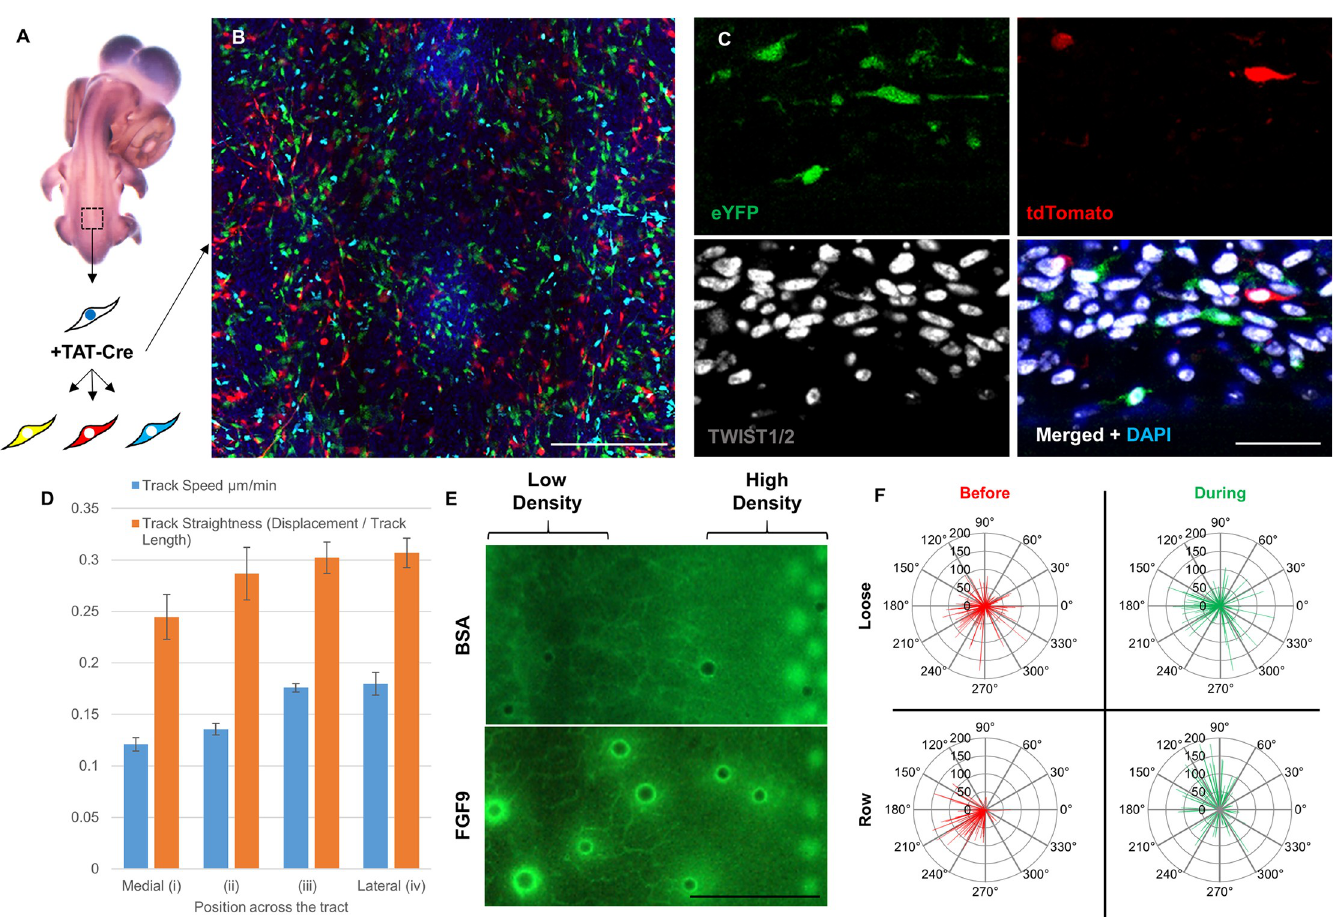
Fig 6. Individual mesenchymal cell movement and morphology are unaffected by cell density. (A) Cells of the Chameleon line express Nuclear Blue until exposure to Cre recombinase, which causes cells to express one of three colours of cytoplasmic fluorescent proteins: red, cyan, or yellow. (B) E6 Chameleon skin treated with TAT-Cre and cultured for 24 hours, demonstrating sparse labelling of cells. Two feather condensates are present at the midline (vertical centre). Scale bar: 200 μ m. (C) Frozen transverse section of TAT-Cre labelled Chameleon mesenchyme. Colocalisation of nuclear TWIST1/2 staining (a marker of mesenchymal cells, white) and cytoplasmic tdTomato or eYFP (shown as green) confirms that labelled cells have dermal mesenchymal identity. Scale bar: 20 μ m. (D) Mesenchymal cell speed and track straightness plotted for each region of skin, from medial (i) and intermediate (ii, iii) to lateral (iv). Analysis derived from confocal time-lapse imaging of labelled E6.5 Chameleon skin explants cultured for 24 hours. Error bars indicate S.E.M. (E) CAG-GFP explants cultured for 24 hours carrying either BSA- or FGF9-coated beads across the presumptive dorsal tract (high density) and intertract loose mesenchyme (low density). Scale bar: 1 mm. (F) Angle plots showing direction of individual mesenchymal cell movement in the 10 hours before and the 10 hours during the formation of a feather primordium row (Row) or the same time period in loose mesenchyme that does not form feather primordia (Loose). Line length indicates cell movement track length. Midline: 180˚, Anterior: 90˚. The numerical values for D and F can be found in S6 Data. BSA, bovine serum albumin; E, embryonic day; eYFP, enhanced yellow fluorescent protein; FGF, fibroblast growth factor.